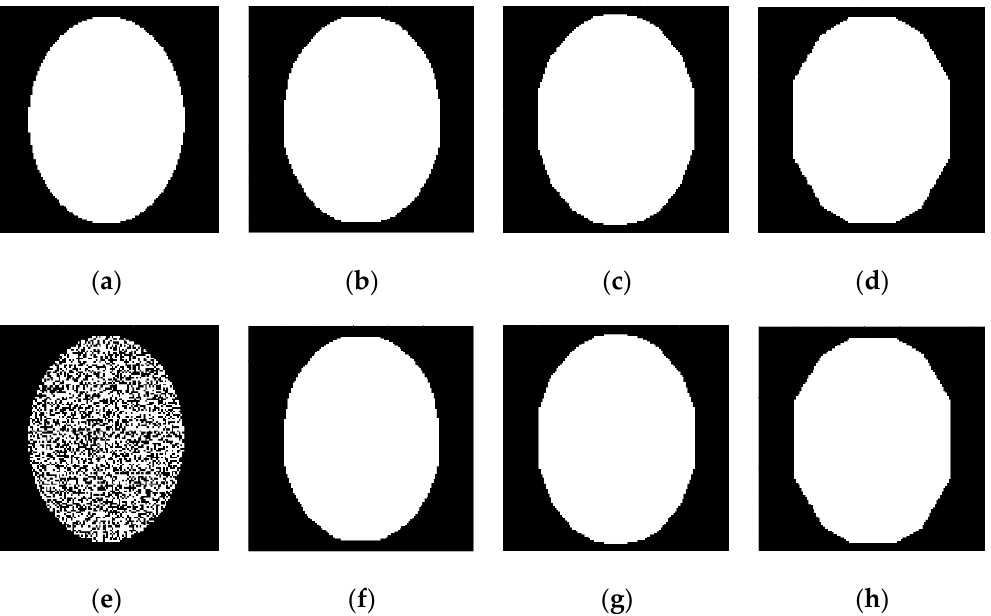
Figure 12. Reconstruction of two ellipses, using their different under-sampled sinograms. ( a ) Original ellipse; ( b – d ) Reconstructed images for 18, 9, and 6 projection angles, correspondingly; ( e ) Original strong noisy ellipse; ( f – h ) Reconstructed images for 18, 9, and 6 projection angles, correspondingly.